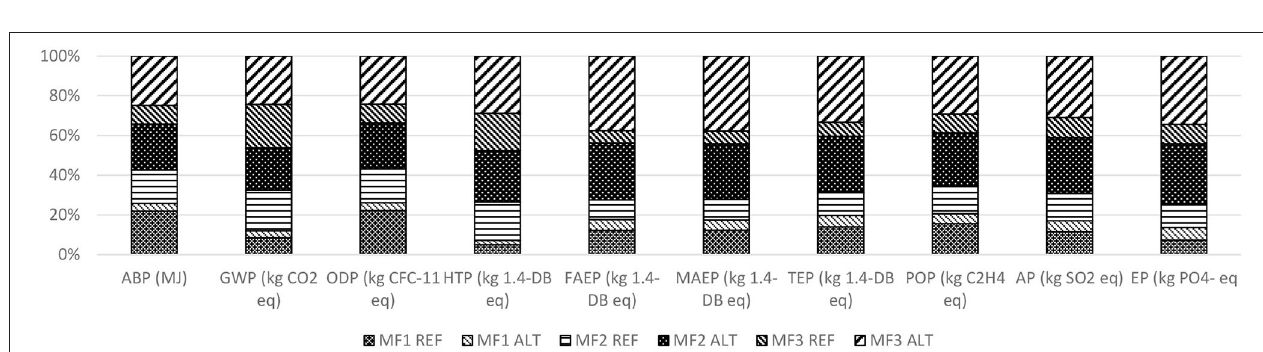
FIGURE 5 | A comparison between the Scenario 1 – Reference and Scenario 2 (Sc2). In this figure the impacts of the reference are treated as 100% and a comparison between the impact categories and the transportation categories is made.